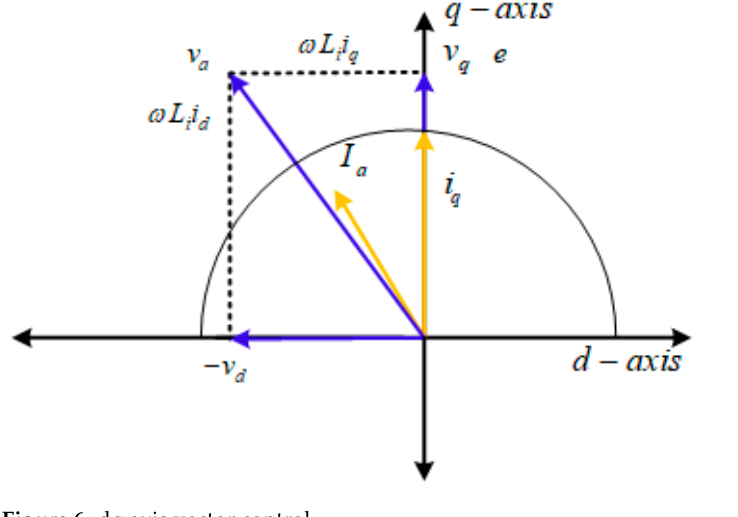
Figure 6. dq axis vector control.